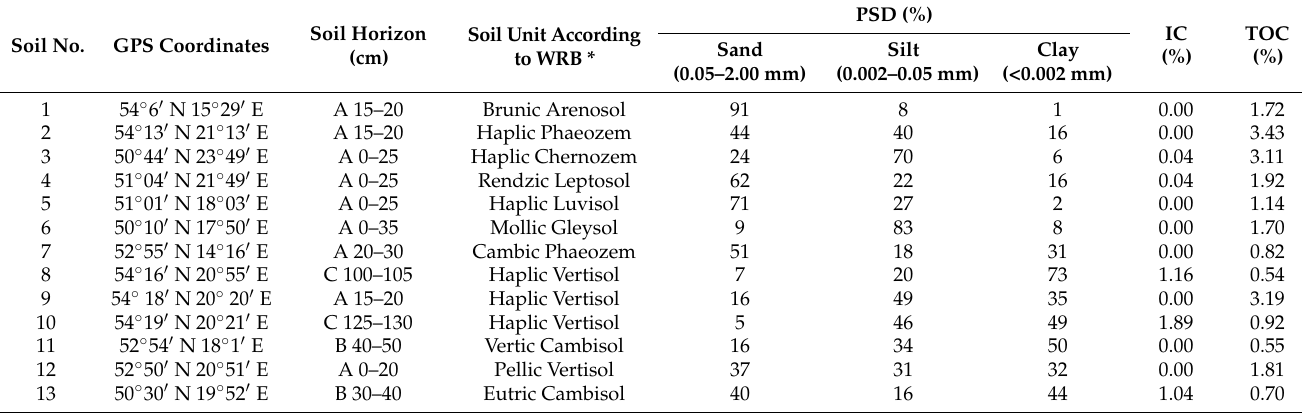
soils—measured with a Shimadzu TOC VCPH coupled with a Shimadzu SSM5000 * World Reference Base for Soil Resources 2014: International Soil Classification System for Naming Soils and Creating Legends for Soil (Shimadzu, Kyoto, Japan)—are presented in Table 1. Maps. Update 2015 [30].